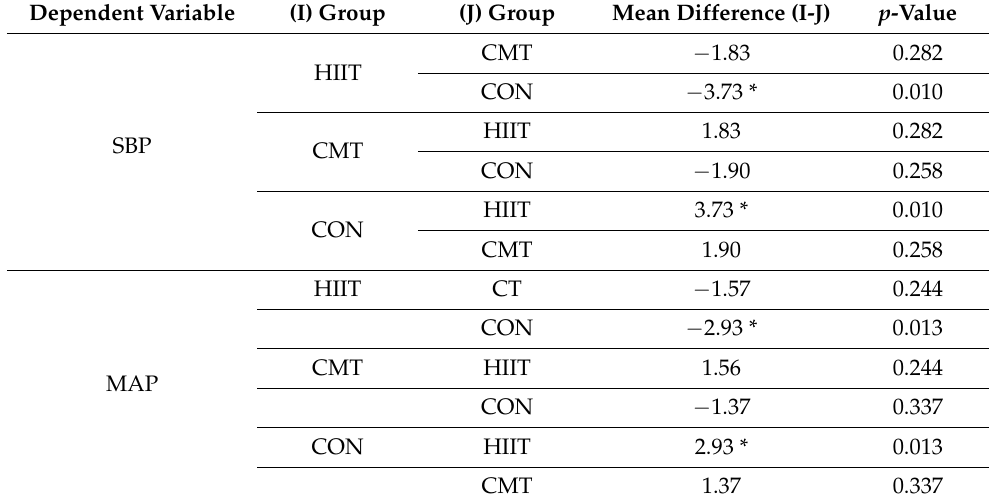
Table 5. Post hoc test (Tukey